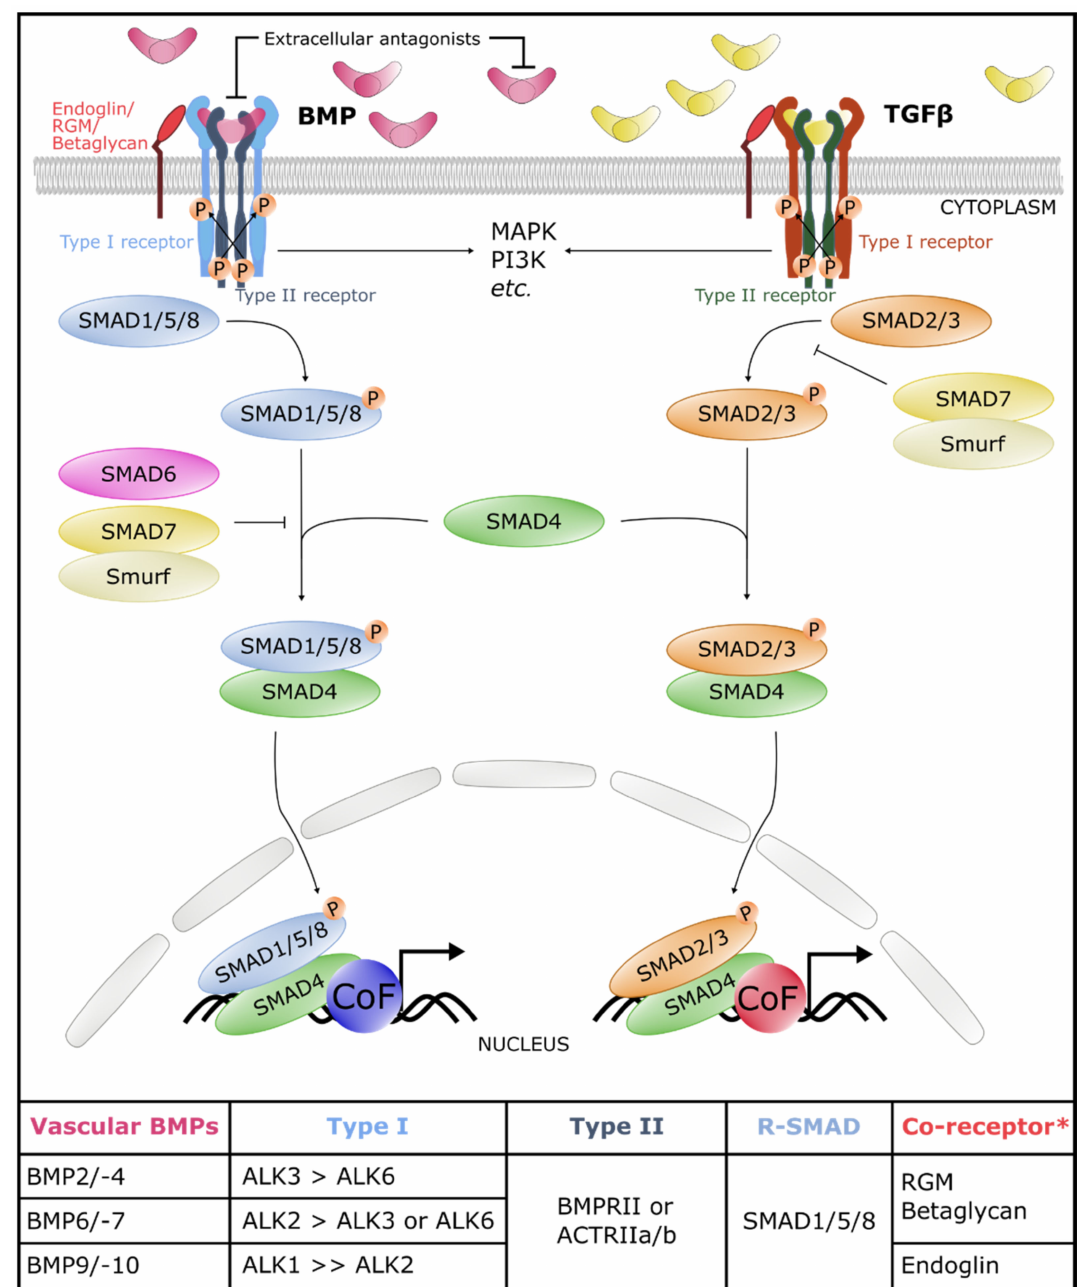
Figure 1. Core of the BMP- and TGF β -SMAD signaling pathways (details are provided in the text). The lower part of this figure represents the main interaction specificities of the different types of BMP ligands. * Co-receptor binding is not necessary for every ligand–receptor combination. Abbreviations: ACTRIIa/b: activin receptor type-2a/b; ALK: activin receptor-like kinase; BMP: bone morphogenetic protein; BMPRII: BMP Type 2 receptor; CoF: co-factors; MAPK: mitogen- activated protein kinase; P: phosphorylation; PI3K: phosphoinositide 3 kinases; RGM: repulsive guidance molecules; R-SMAD: receptor-regulated SMAD protein; Smurf: SMAD ubiquitin regulatory factors; TGF β : transforming growth factor β